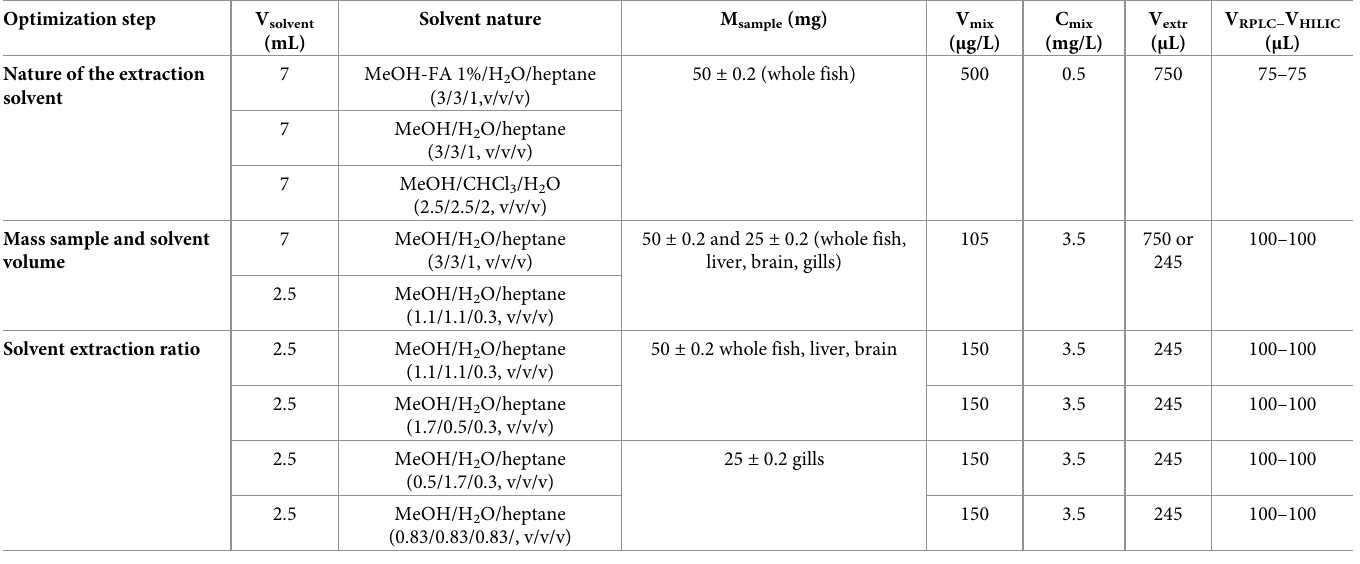
Table 1. Mass of sample (M sample ), nature and volume of extraction solvent (V solvent ), volume (V mix ) and concentration (C mix ) of IS mixture, extracted (V extr ) and reconstitution volumes for RPLC (V RPLC ) and HILIC (V HILIC ) used during the optimization of the sample preparation